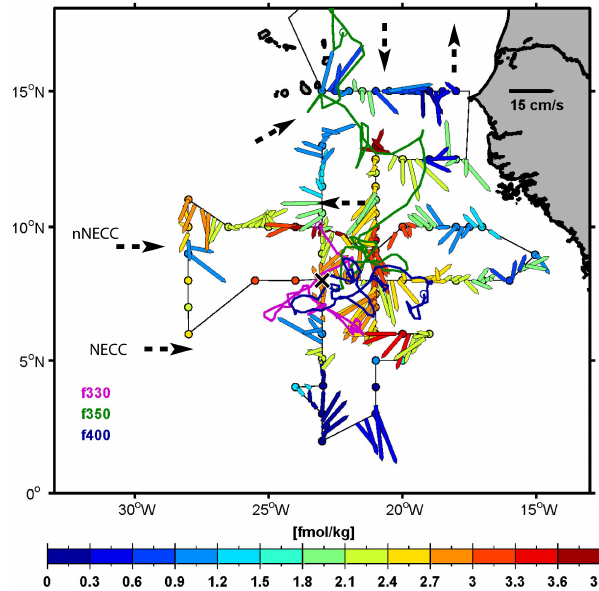
Figure 10. Horizontal distribution of ADCP velocity vectors con- verted to the isopycnal σ θ = 26.88kgm − 3 recorded in November and December 2009 with current vectors interpolated on 0.25 ◦ in- tervals colored with the maximum tracer (CF 3 SF 5 ) concentration (in fmolkg − 1 ) of the nearest CTD bottle measurements near this isopycnal. Open arrows only show velocity information because no tracer was sampled. The black × with a white frame at ∼ 8 ◦ N, 23 ◦ W shows the deployment location where the tracer and the three floats were deployed in April 2008. The three float tracks for the pe- riod April 2008 to December 2009 are included as red, green and blue curves with a circle for the December 2009 location. The main current field is indicated by dashed black arrows.